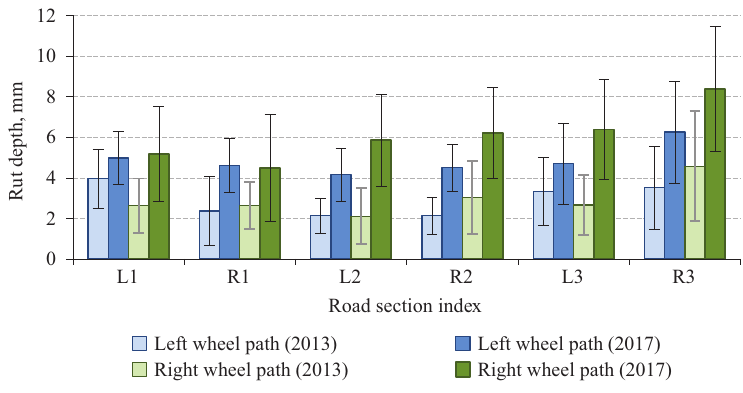
Figure 6. Mean of rut depth in 2013 and 2017